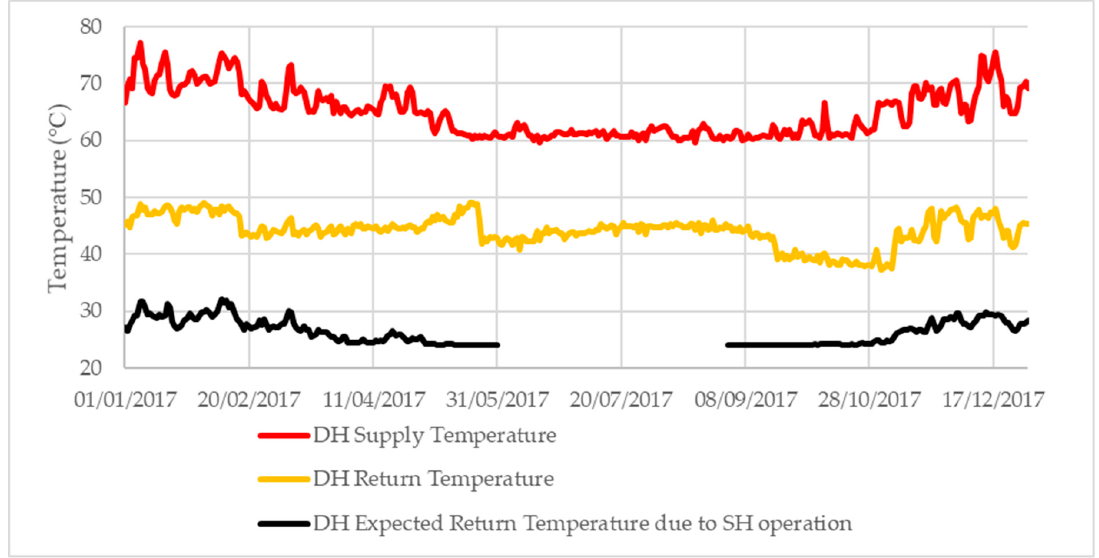
Figure 6. The daily average DH supply and return temperature measured by the energy meter in the substation of the building case study, and the calculated expected DH return temperature due to the ideal operation of the radiator system during 2017.